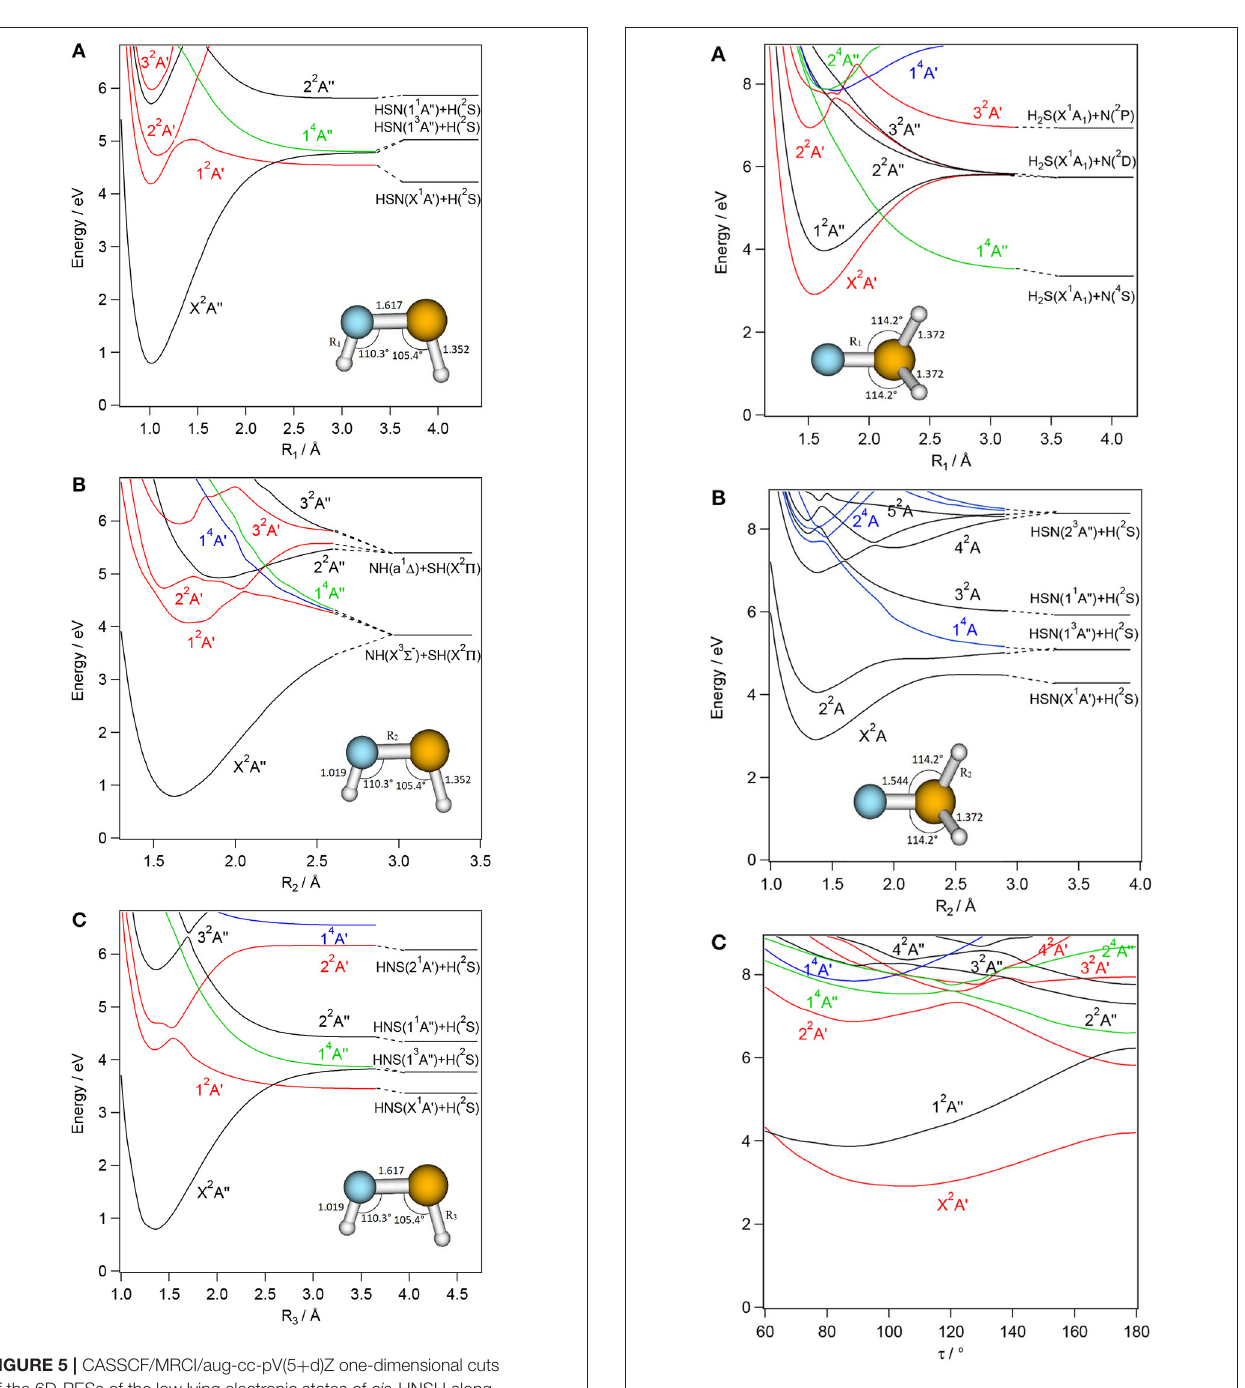
FIGURE 6 | CASSCF/MRCI/aug-cc-pV(5 + d)Z one dimensional cuts of the 6D-PESs of the low lying electronic states of H 2 SN along the NS (R 1 , A ) and NH (R 2 , B ) stretching coordinates and τ torsion, (C) coordinate. The remaining internal coordinates are kept fixed at their values in the H 2 SN(X 2 A ′ ) state i.e., R 1 = 1.544 Å, R 2 = R 3 = 1.372 Å, θ 1 = θ 2 = 114.2 ◦ , and τ = 104.1 ◦ . The H + HNS/HSN and H 2 S + N asymptotes are located using the data in Supplementary Tables 6 , 7 and (Trabelsi et al., 2015) 1 . The reference energy is that of H 2 NS(X 2 B 1 ) at